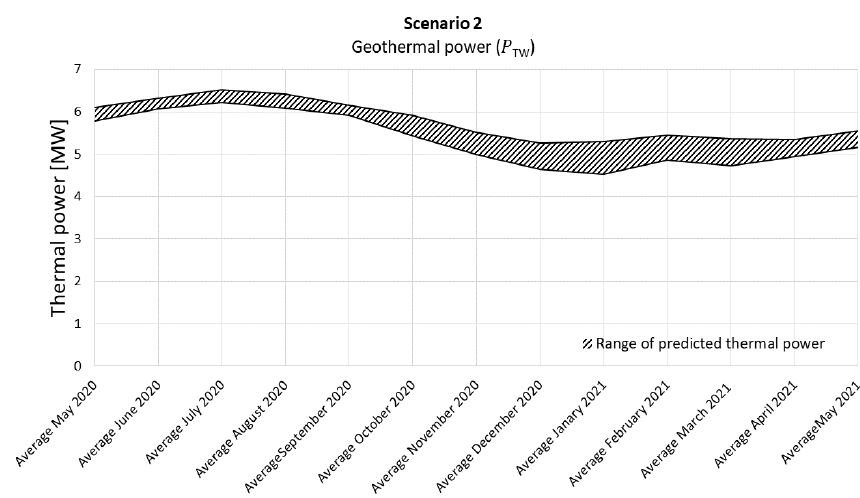
Figure 10. Range of possible thermal power [MW], which might be available during the operational phase of the tunnel for Scenario 2.